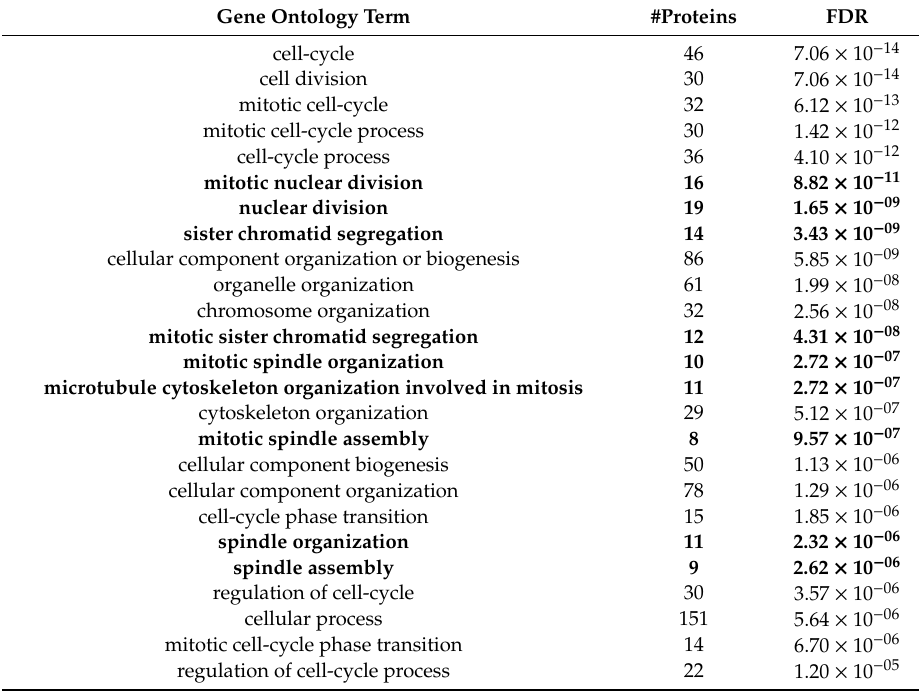
Table 2. Top 25 biological processes related to the downregulated proteins. The first column represents the biological process. The second column is the number of downregulated proteins through increased miR195 / 497 expression in RKO or HCT116 cells in the dataset related to that process. In bold the processes involved in mitosis. FDR: False Discovery